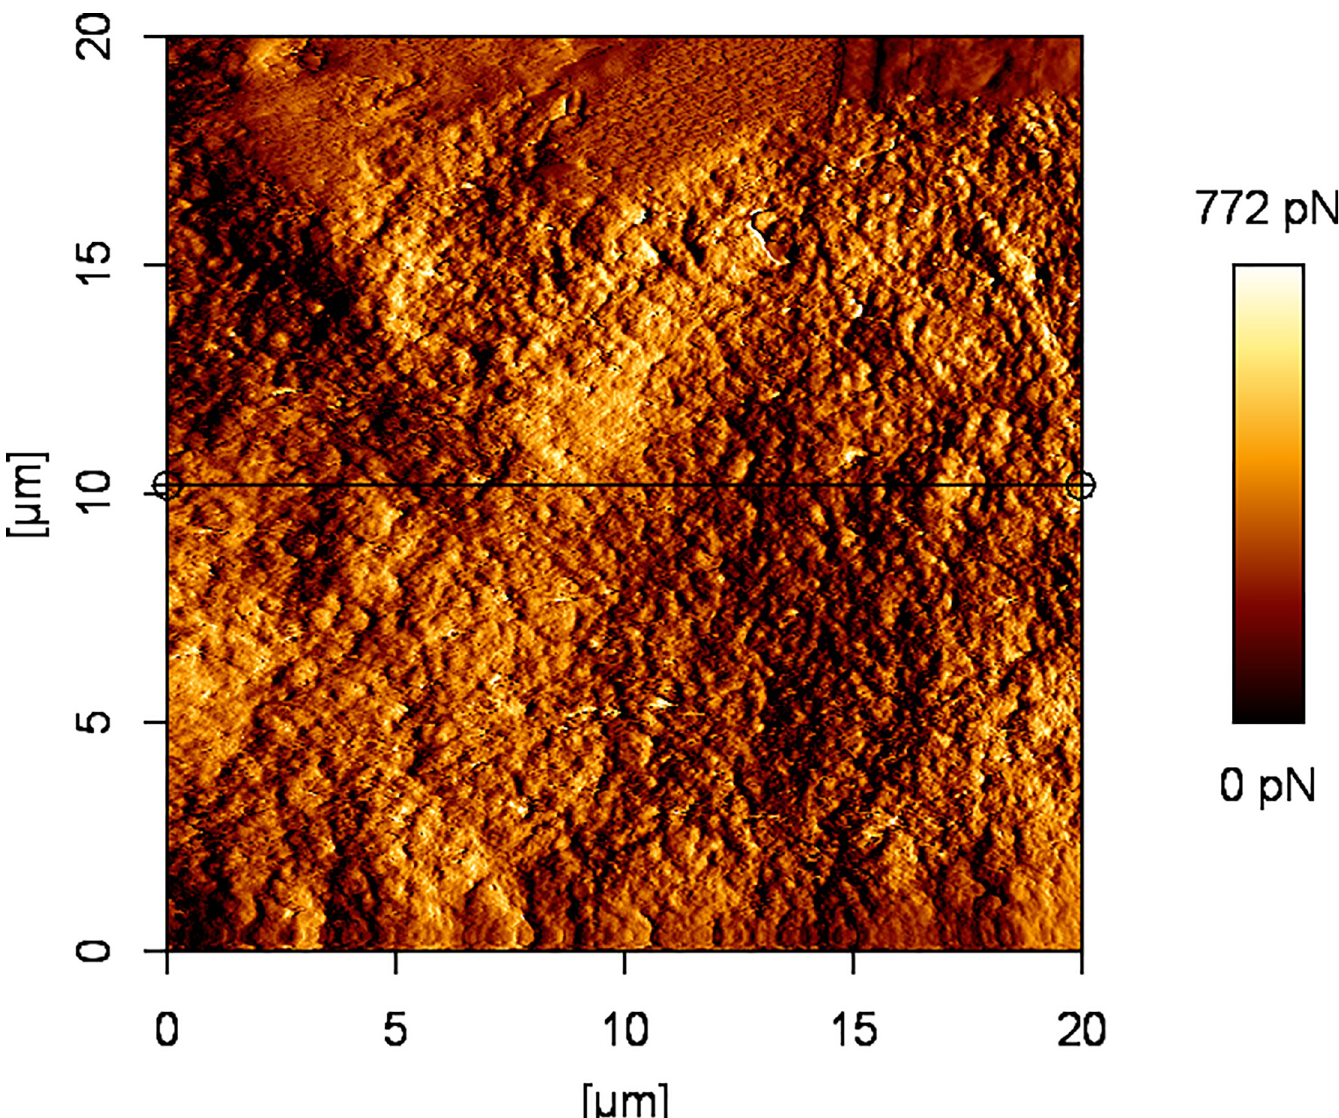
Fig 6. Example image of corneal surface treated with FS2 with AFM vertical